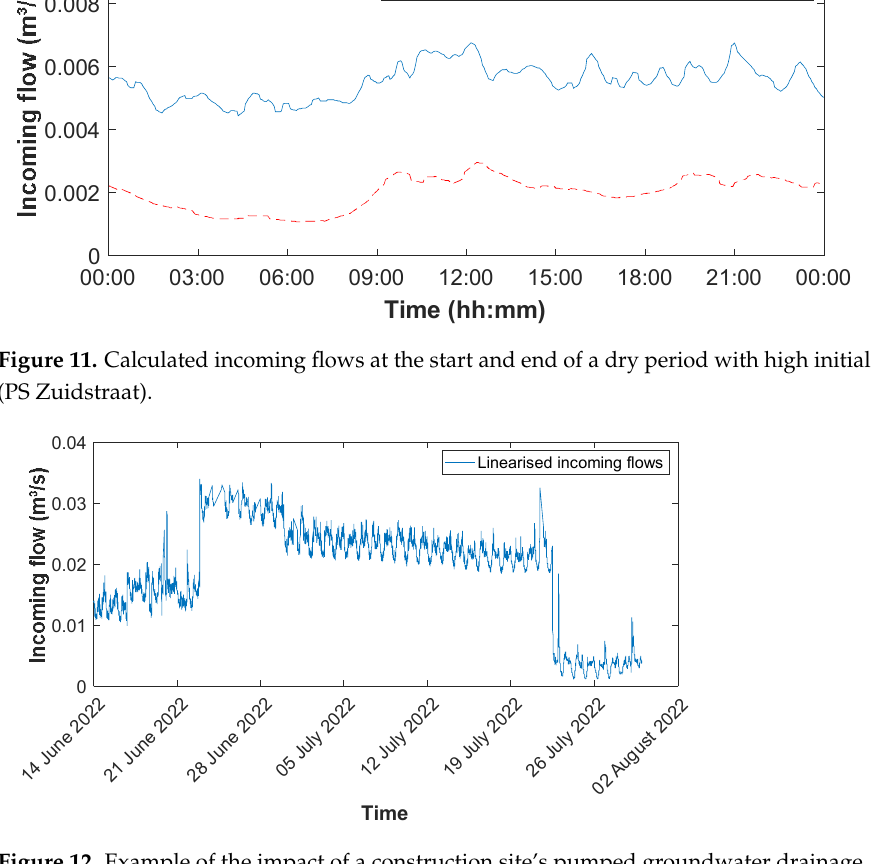
Figure 12. Example of the impact of a construction site’s pumped groundwater drainage. The inflow period extends from 22 June 2022 to 22 July 2022. (PS Wauberg).